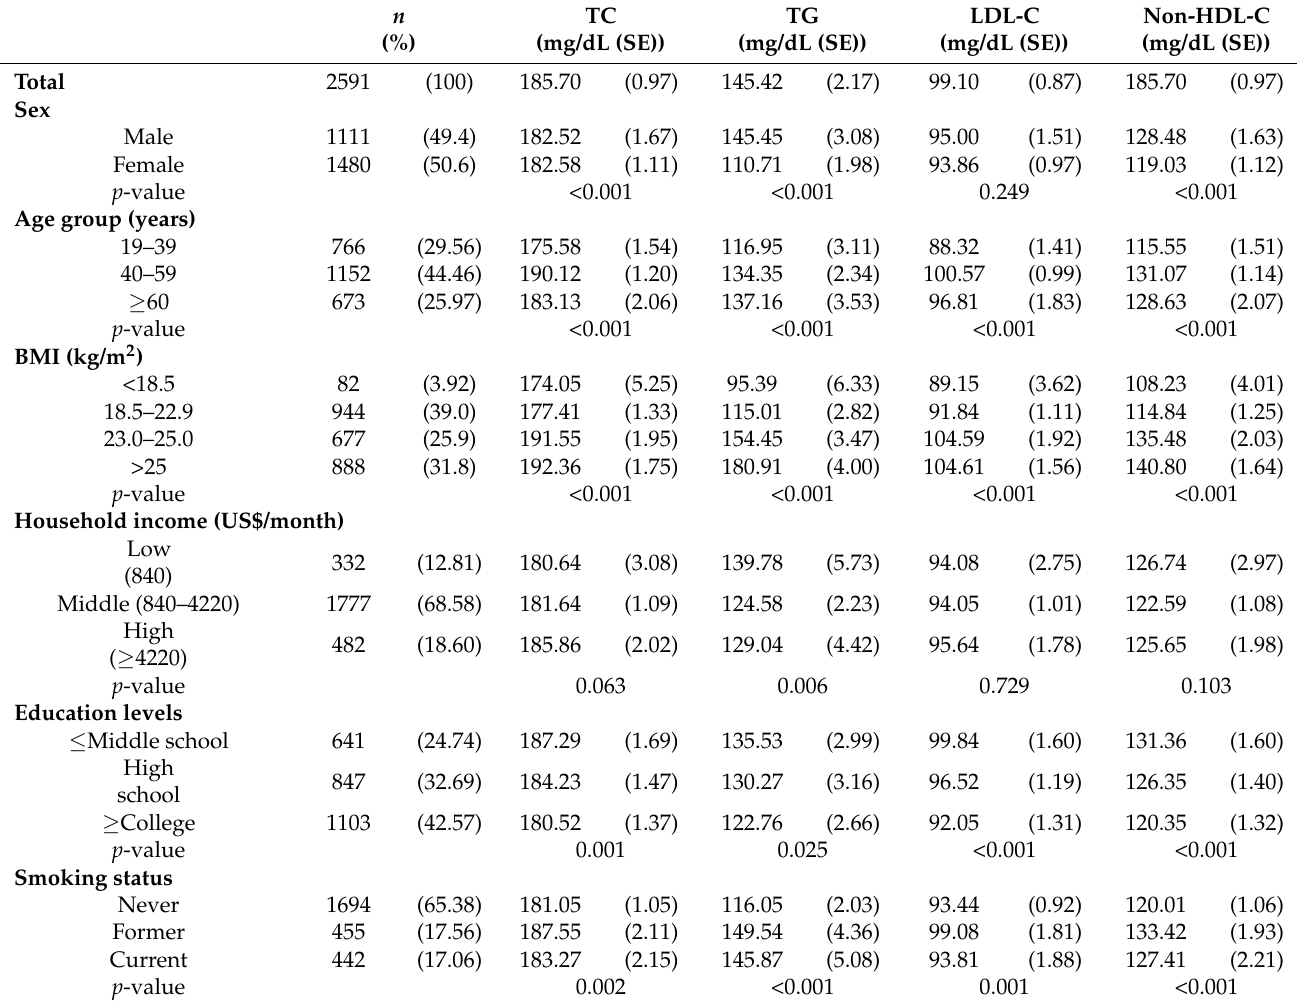
Table 1. Arithmetic means (mg/dL) of serum lipid profiles (mg/dL) in participants ( n = 2591) by demographic